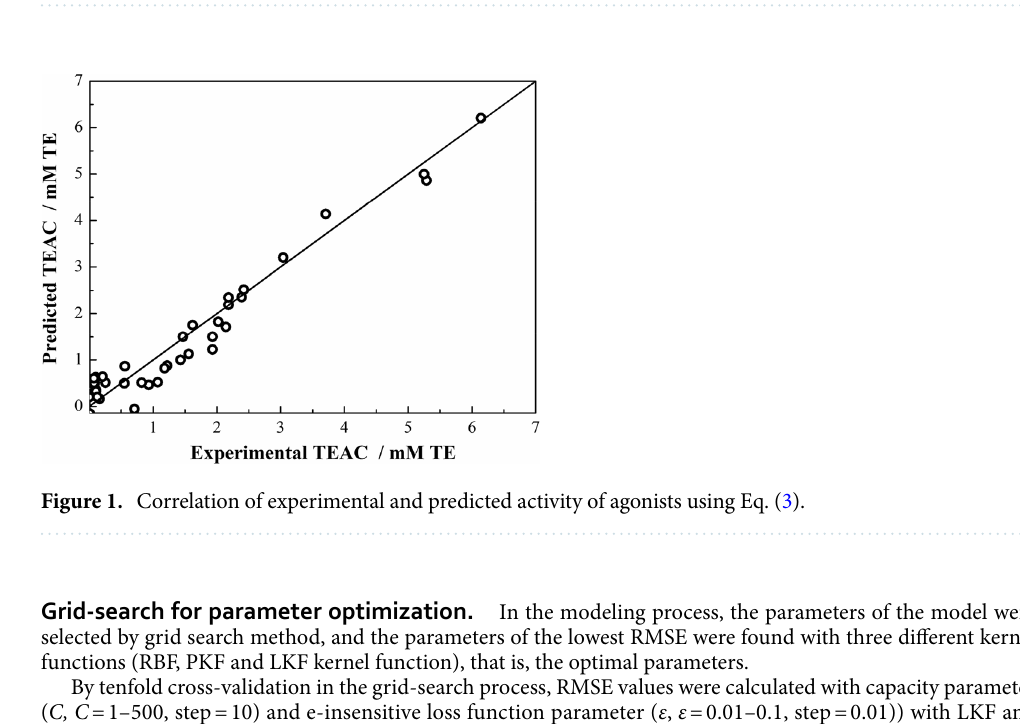
Table 1. Molecular descriptors involved in the QSAR models.